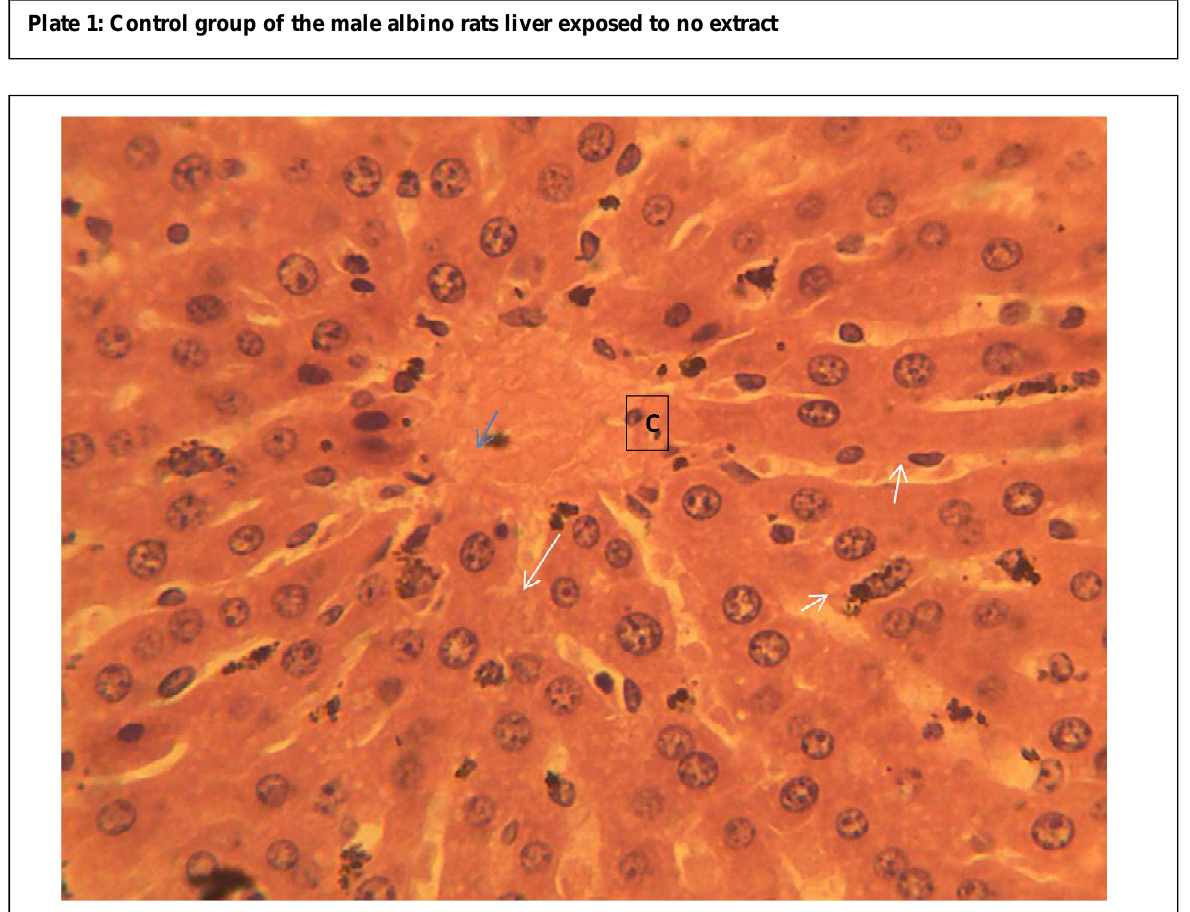
Plate 2: Male liver of the group exposed to 200 mg/kg of aqueous